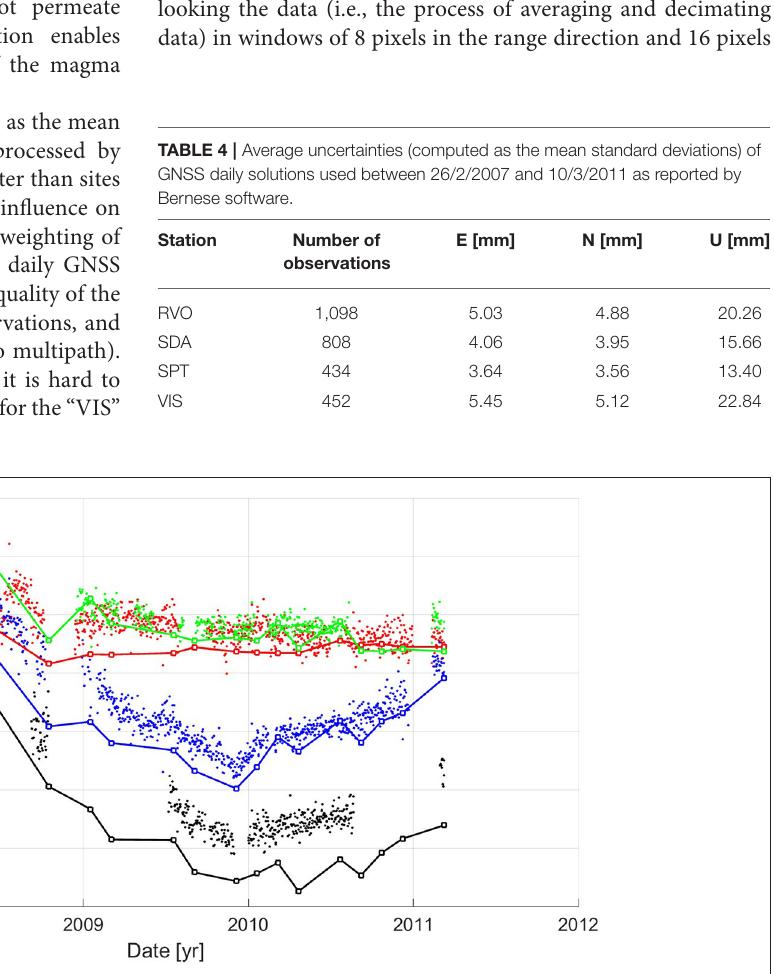
Frontiers in Earth Science |